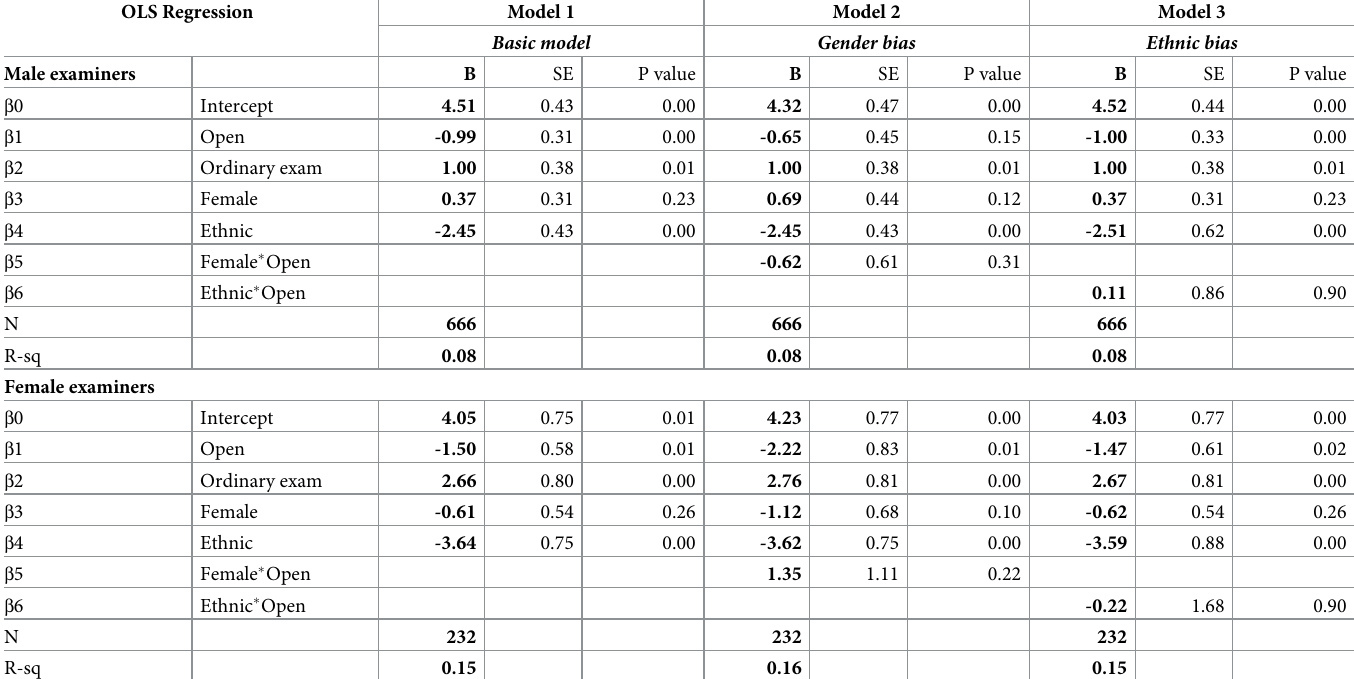
Table 3. Examiner’s gender and grading